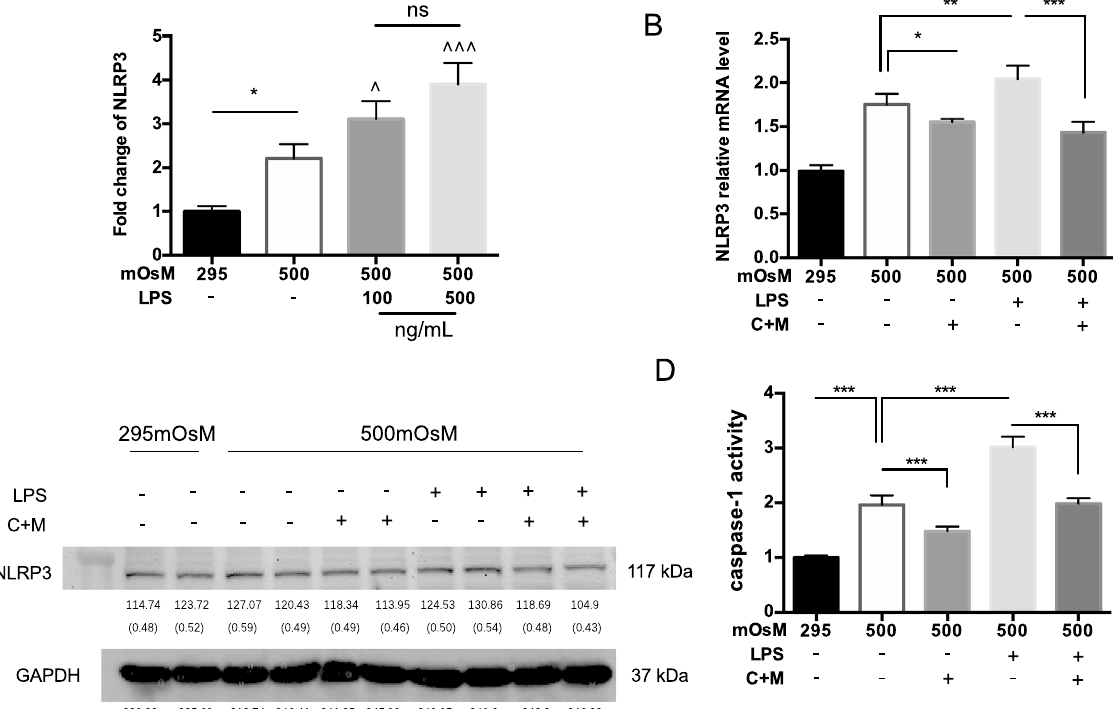
Figure 8. Combined CMC + α-MSH treatment reduced the enhancement of NLRP3 expression and caspase-1 activity in LPS-stimulated HCECs exposed to hyperosmotic environmental stress. ( A ) mRNA transcription of cell lysates derived from HCECs treated with LPS (100 ng/ml, 500 ng/ml) in a hyperosmotic environment or left untreated for the indicated times (n = 6). ( B , C ) Western blot and real-time PCR analyses of NLRP3 expression in HCECs treated with or without LPS (100 ng/ml), with or without CMC + α-MSH, in a hyperosmotic environment or left untreated for the indicated times (n = 6). ( D ) Examination of caspase-1 activity among the groups indicated in ( B ) (n = 6). Data are shown as mean ± SEM. Three independent experiments were performed. The samples derive from the same experiment and that gels/blots were processed in parallel. ( C ) Showed the cropped gels and blots and full-length blots are presented in Supplementary Fig. S8C. * p < 0.05; ** p < 0.01; *** p <